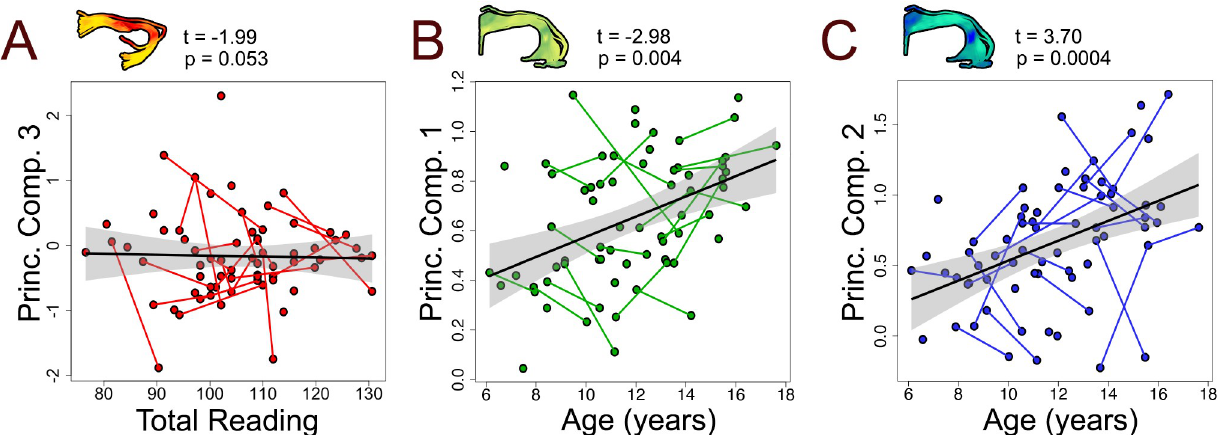
Fig 5. Scatterplots visualizing relationships between principal component 3 (PC3) and Total Reading in the left uncinate fasciculus (A), PC1 and age in the left uncinate (B) and PC2 and age in the left uncinate (C). Principal components are shown in an example tract for each relationship. Increases in PC1 indicate increased diffusion along a primary axis, while increases in PC2 indicate increased myelin and axon packing, thus relationships depicted in panels A and B could potentially reflect axonal maturation. No significant links between principal components and Total Reading were observed. The relationship between PC3 and Total Reading in the left uncinate was closest to our significance